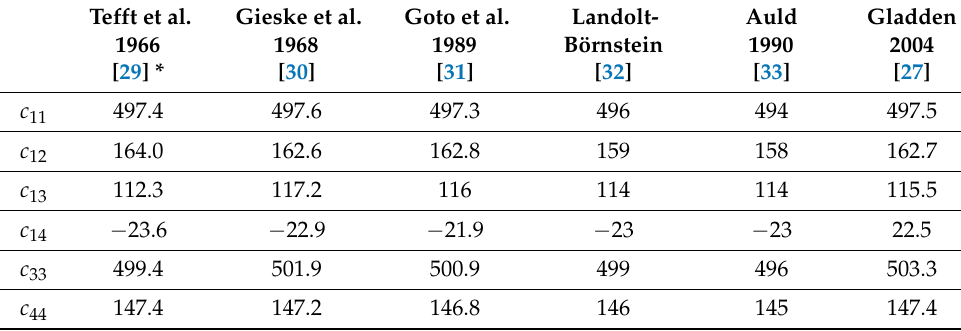
Table 3. Elastic constants c µν for sapphire, GPa. Tefft et